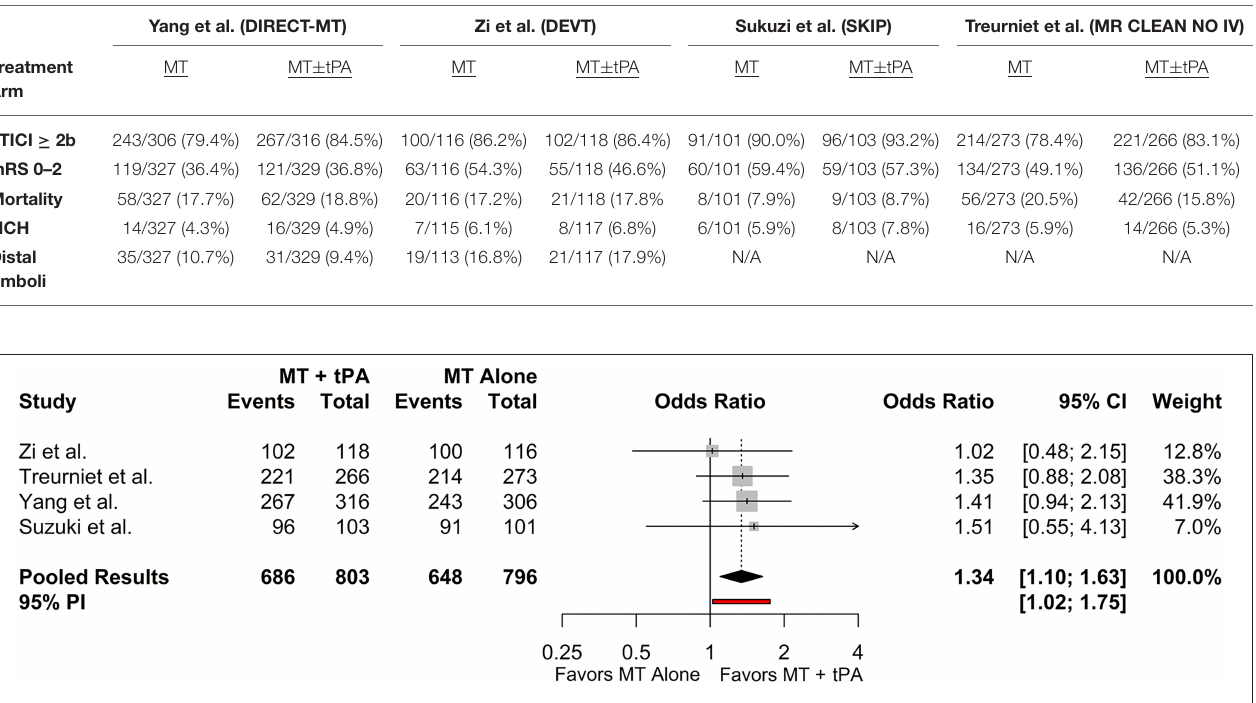
FIGURE 2 | Forest plot of comparisons of eTICI ≥ 2b. Pooled results were computed via the Mantel-Haenszel method, using restricted effects maximum likelihood for estimation of the between-study variance component and Hartung-Knapp adjustment to calculate a 95% confidence interval (CI) around the pooled effect size. A 95% prediction interval (PI) for the pooled results are also displayed as a red bar.